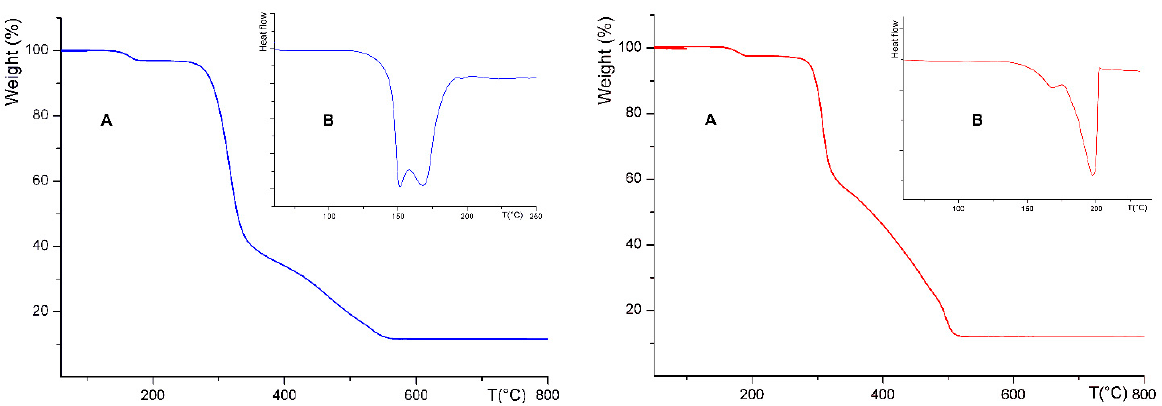
Figure 3. TGA (Section A) and DSC (Section B) curves for Ac1 (blue lines) and Ac2 (red lines) crystalline samples.